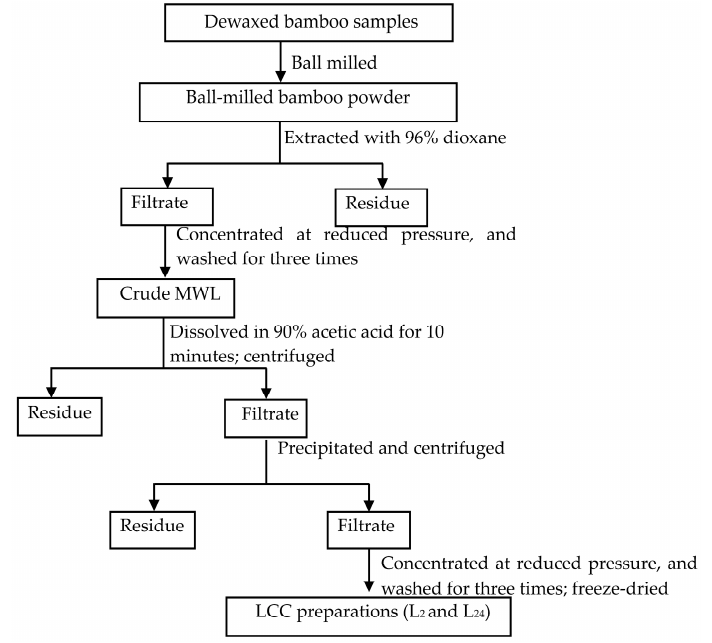
Figure 4. Scheme for LCC preparations (L 2 and L 24 ) isolated from 2-month-old and 24-month-old bamboo ( Neosinocalamus affinis ) crude milled wood lignin (MWL).